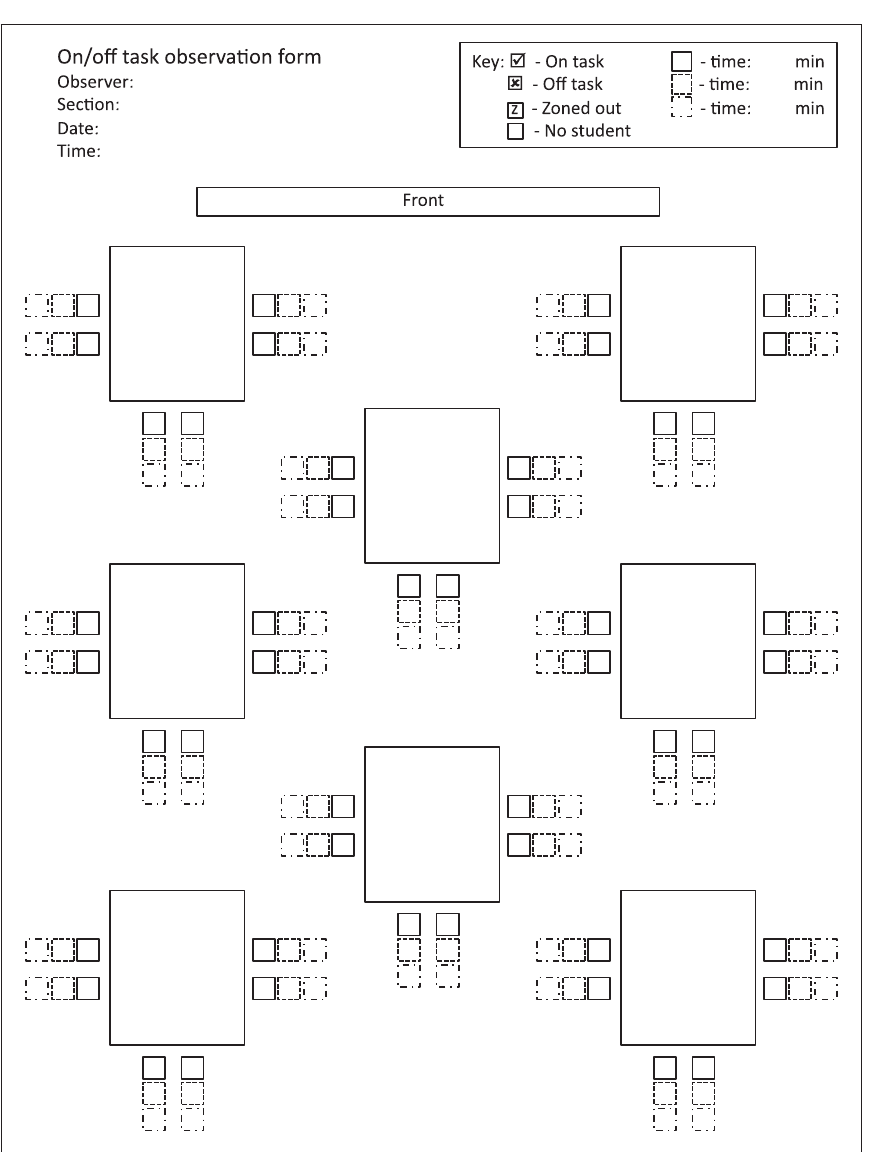
FIG. 8. The on-off task form. The form is a spatial map of the lab on which the observer records student engagement. Each form allows three snapshots of engagement to be